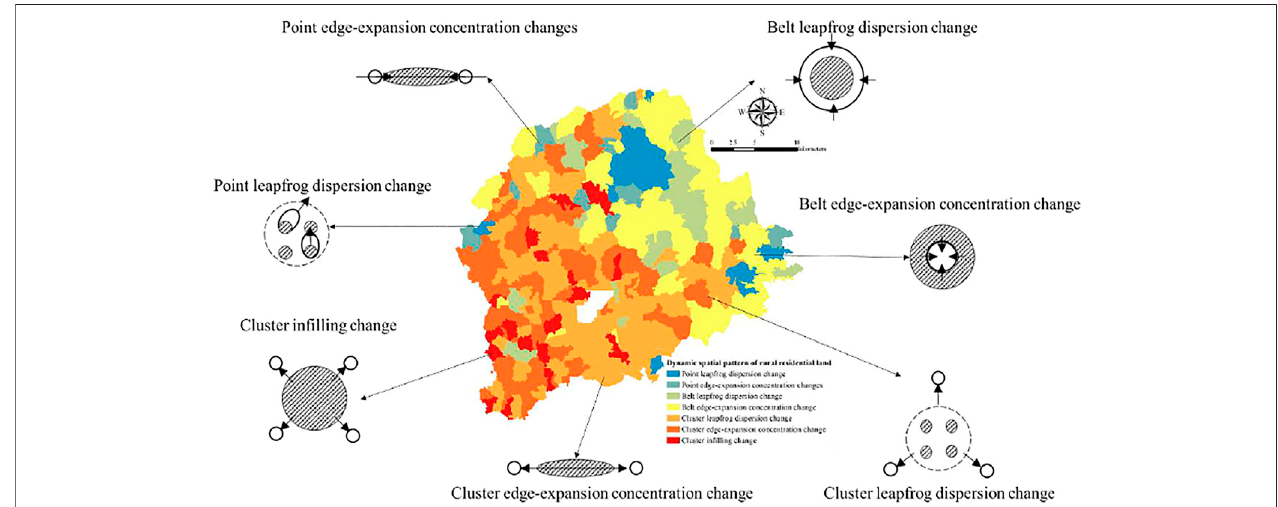
FIGURE 7 | Distribution of dynamic spatial patterns of RRL in Pinggu.